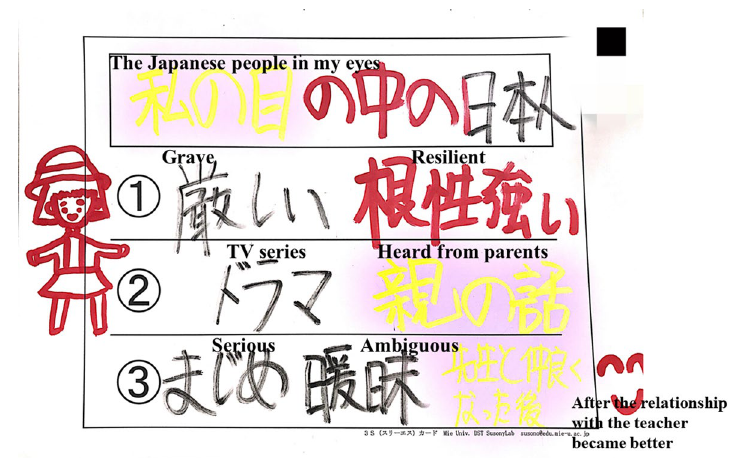
Fig. 3 An example of the worksheet used in Learning Activity